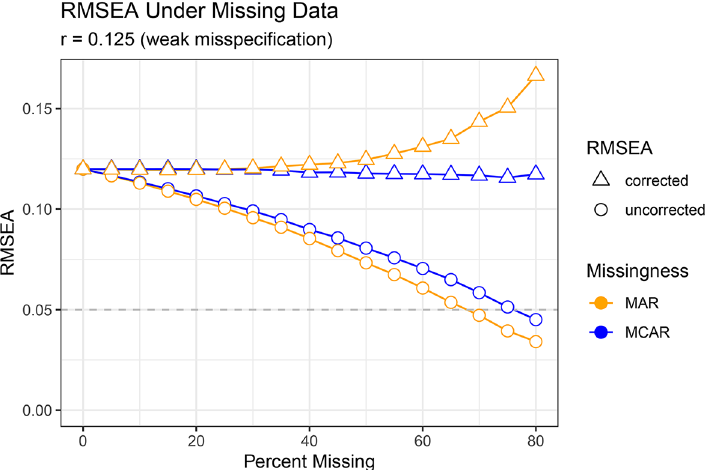
Note . RMSEA values are given for data completely missing at random (MCAR; blue) and data missing at random (MAR; orange). While KL -corrected RMSEA values (shown as triangles) remain mostly constant